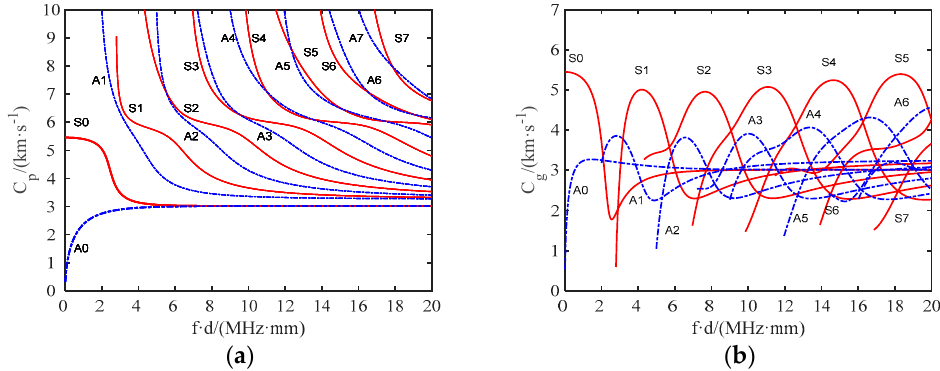
Figure 4. ( a ) Dispersion curve of the phase velocity; ( b ) dispersion curve of the group velocity.